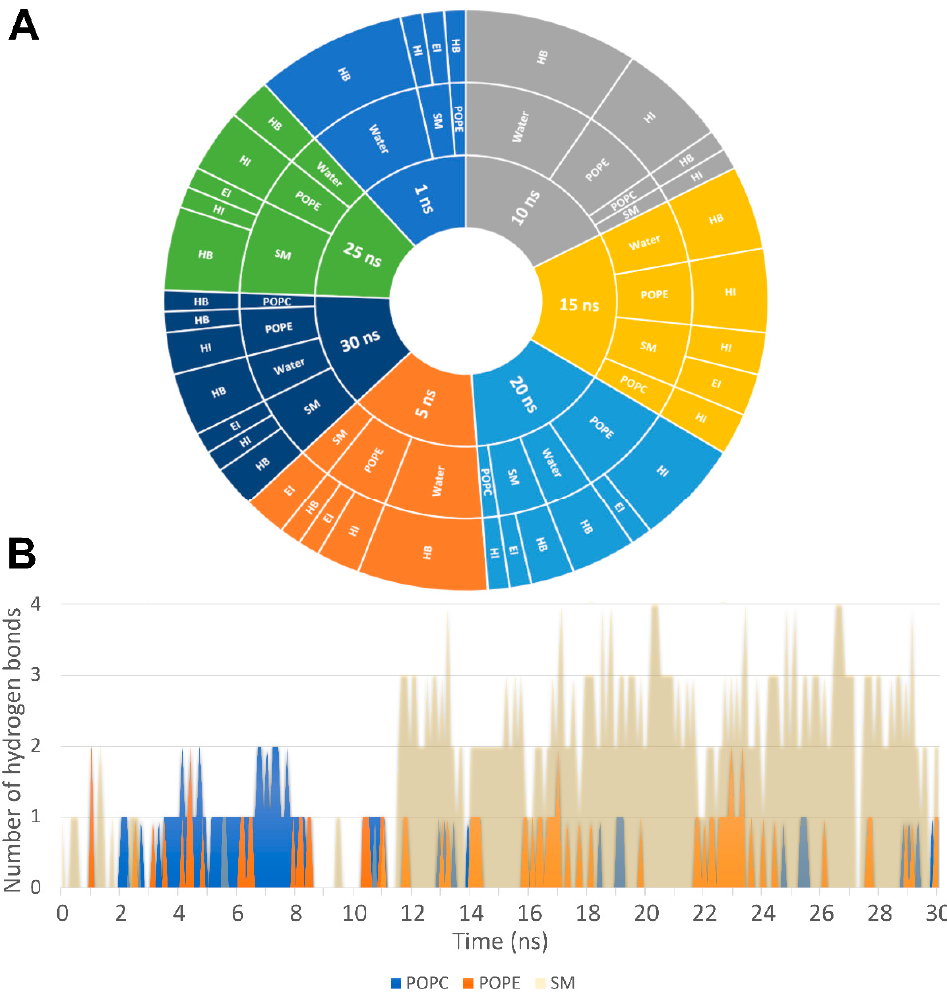
Figure 3. Intermolecular interactions between Bz-Im and the erythrocyte membrane system ( A ) at 1 ns (blue color), 5 ns (orange color), 10 ns (gray color), 15 ns (yellow color), 20 ns (light blue color), 25 ns (green color), and 30 ns (dark blue color). HB, hydrogen bond; HI, hydrophobic interaction; E, electrostatic interactions ( B ) Hydrogen bonds between Bz-Im and the phospholipids of the system. SM, sphingomyelin; POPC, phosphatidylcholine; POPE, phosphatidylethanolamine.